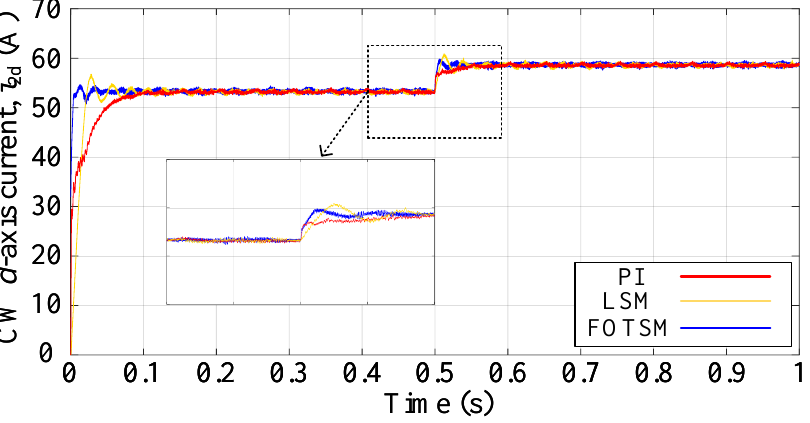
Figure 12. The CW d -axis current responses under PI, LSM, and FOTSM during the voltage change